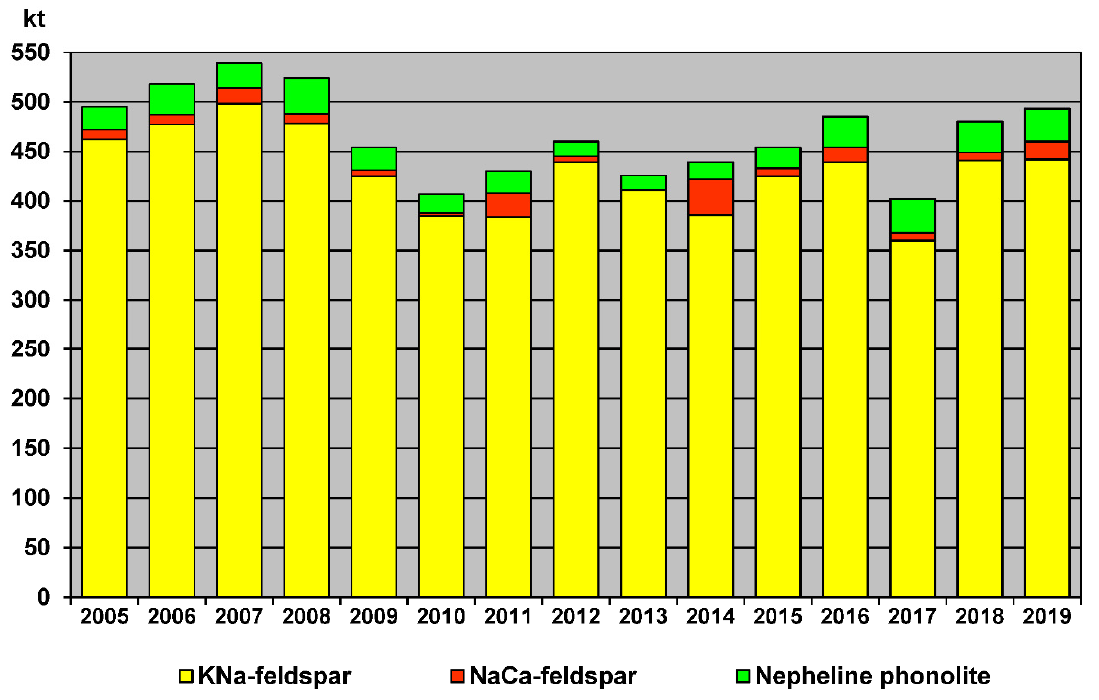
Figure 10. Czech mine production of different feldspar types.